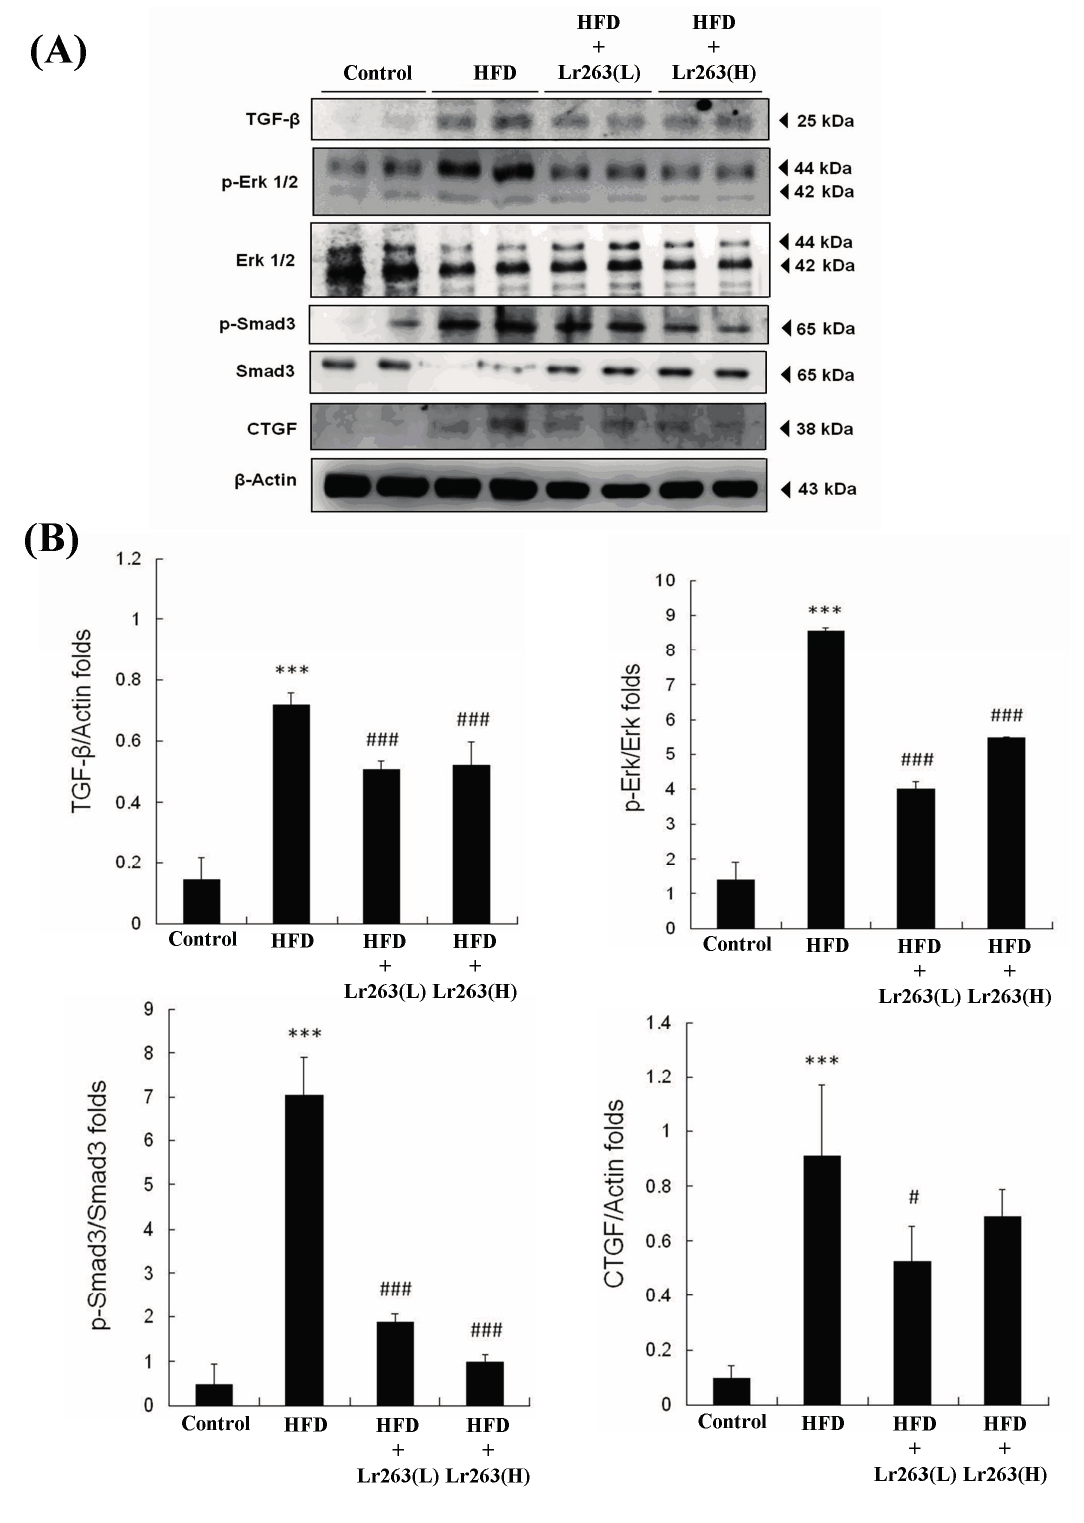
Figure 6. TGF- β pathway protein expression analysis. ( A ) The TGF- β /Smad-3/CTGF expression levels increased in the HFD treatment hamster hearts and decreased in the heat-killed Lr263 (625 and 3125 mg/kg-hamster/day) treatment hamster hearts; ( B ) The normalized protein expression of TGF- β / β -actin, p-Erk/Erk, p-Smad3/Smad3, and CTGF/ β -actin (*** p < 0.001 compared with the control group, # p < 0.05, and ### p < 0.001 compared with the HFD